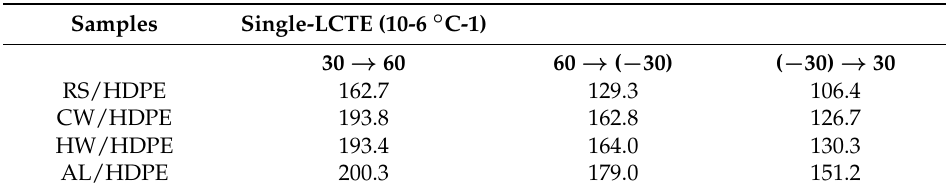
Table 2. Linear coefficient of thermal expansion (LCTE) of the RS/HDPE, CW/HDPE, HW/HDPE, and AL/HDPE measured in the thickness direction at temperatures changing from 30 to 60 ◦ C, 60 to − 30 ◦ C, and − 30 to 30 ◦ C,